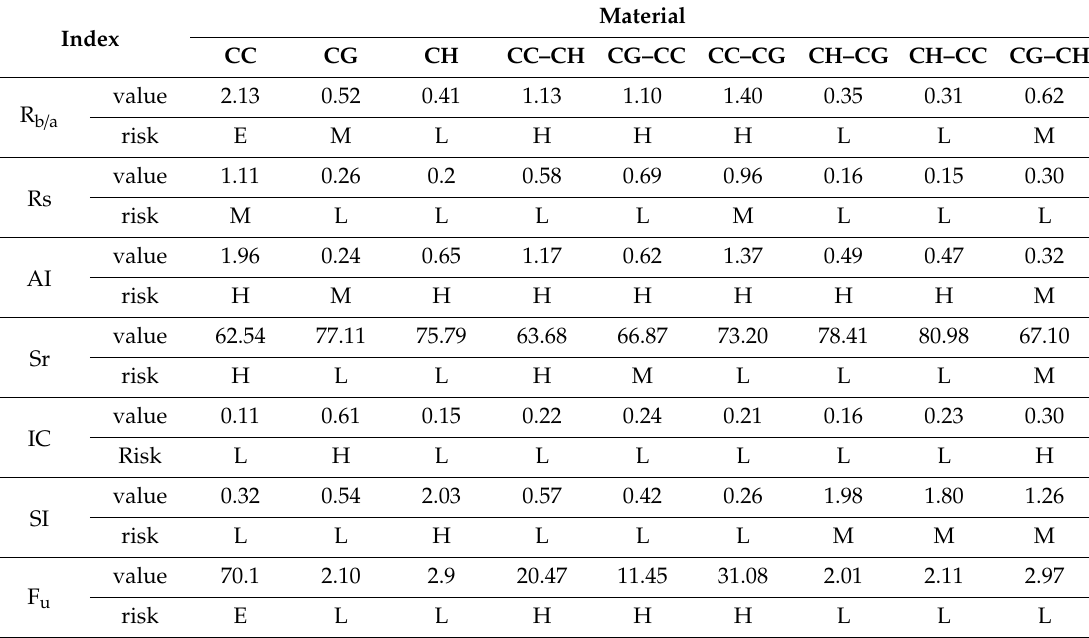
Table 4. Indicators of heating device contamination by ash from the tested